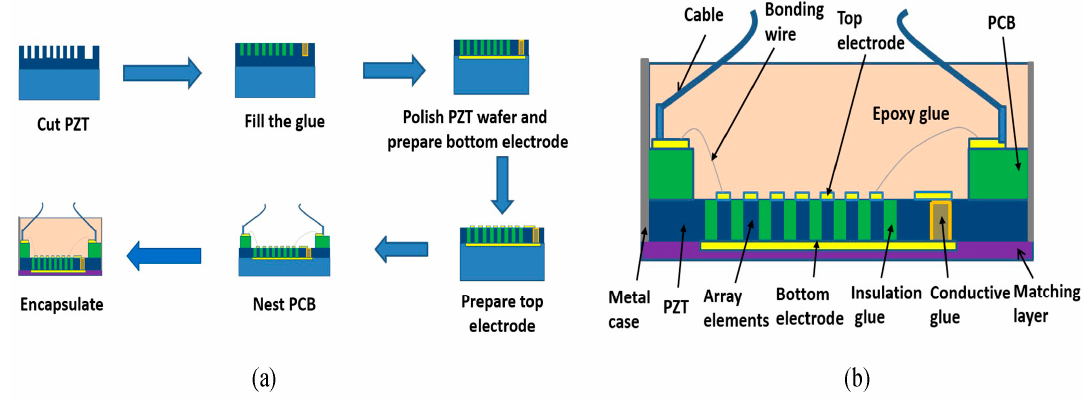
Figure 8. Schematic diagram of fabrication process ( a ) and final prepared transducer ( b ).